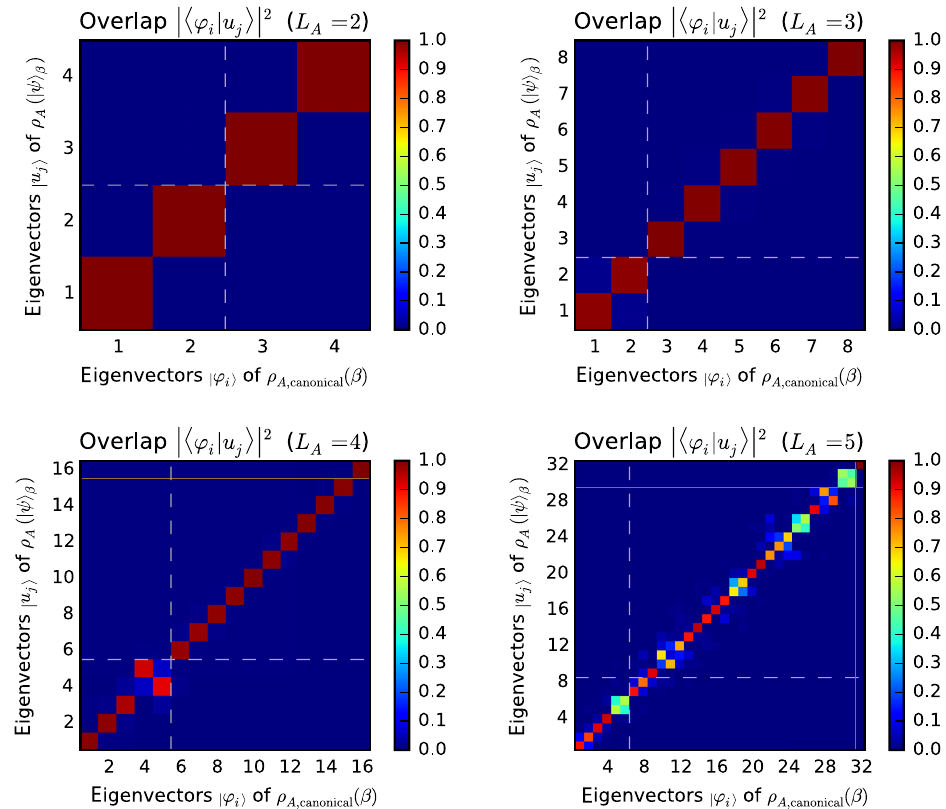
FIG. 9. Overlap between the Schmidt eigenvectors j u L ¼ 21 system with β ¼ 0 . 3 , and subsystem sizes L (largest eigenvalue) to least significant (smallest eigenvalue). The locations of the energy densities e (dashed grey) and e (cid:3) (solid brown) are denoted with lines, as in Fig. 8.